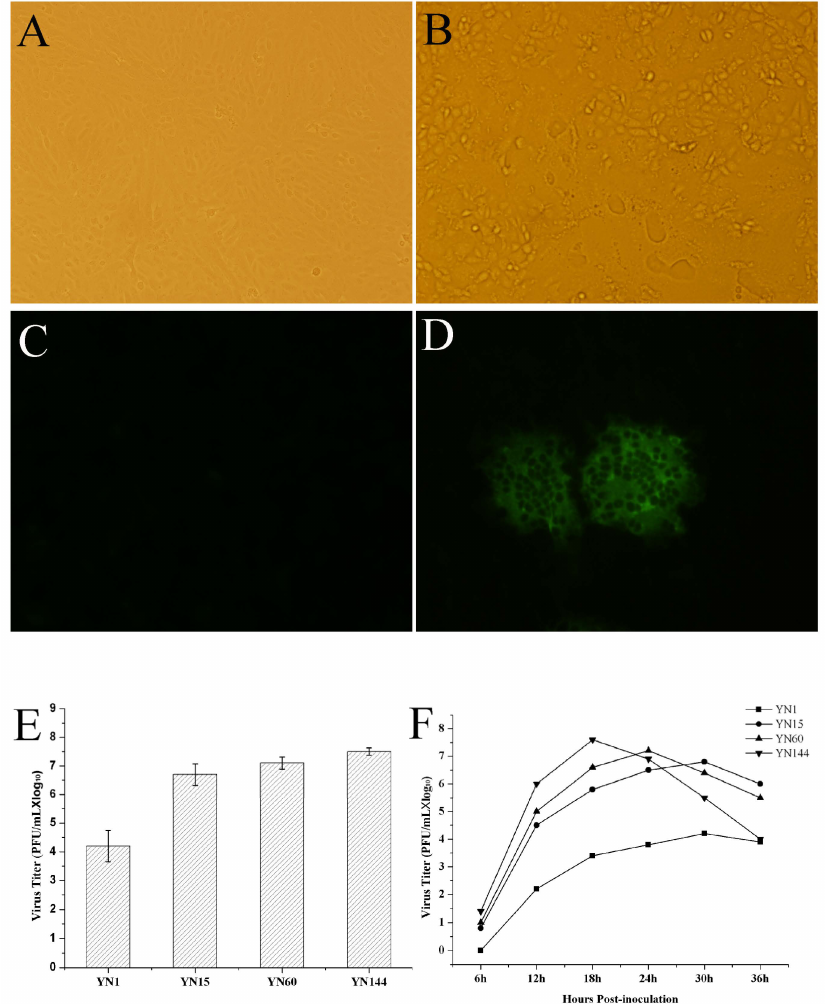
Figure 1. Virus identification, virus titration and propagation kinetic. ( A ) Control Vero cells; ( B ) The cytopathic effects (CPE) of Vero cells infected with YN15 at 24 h post-inoculation; ( C ) Blank control cells in immunofluorescence assay (IFA); ( D ) Fluorescent signal in porcine epidemic diarrhea virus (PEDV)-infected cells; ( E ) Virus titer of YN1, YN15, YN60 and YN144; ( F ) One-step growth curve of YN1, YN15, YN60 and YN144 in Vero